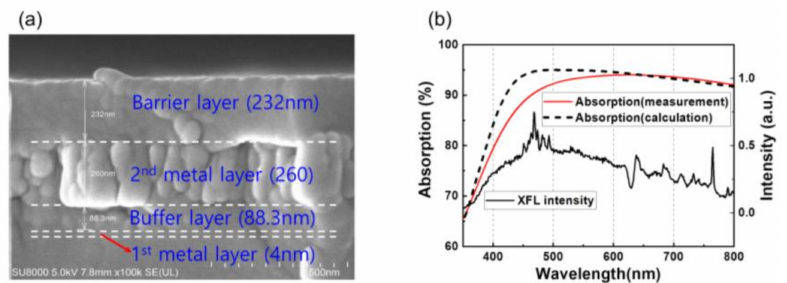
Figure 1. ( a ) SEM image of light to heat conversion layer (LTHC); ( b ) calculation and measurement data of xenon flash lamp (XFL) absorbed by the